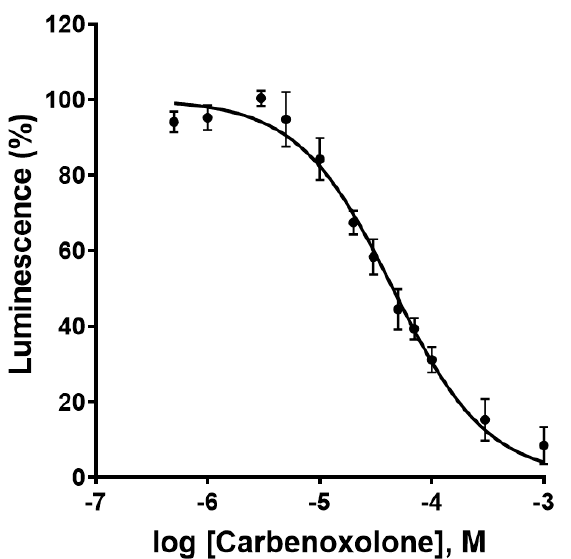
Figure 8. Concentration-dependent inhibition of Cx43 gap junctions by the blocker carbenoxolone as determined in the newly developed assay. Data points represent means ± SEM from 3 separate experiments. IC 50 = 44.5 ± 4.8 μ M.